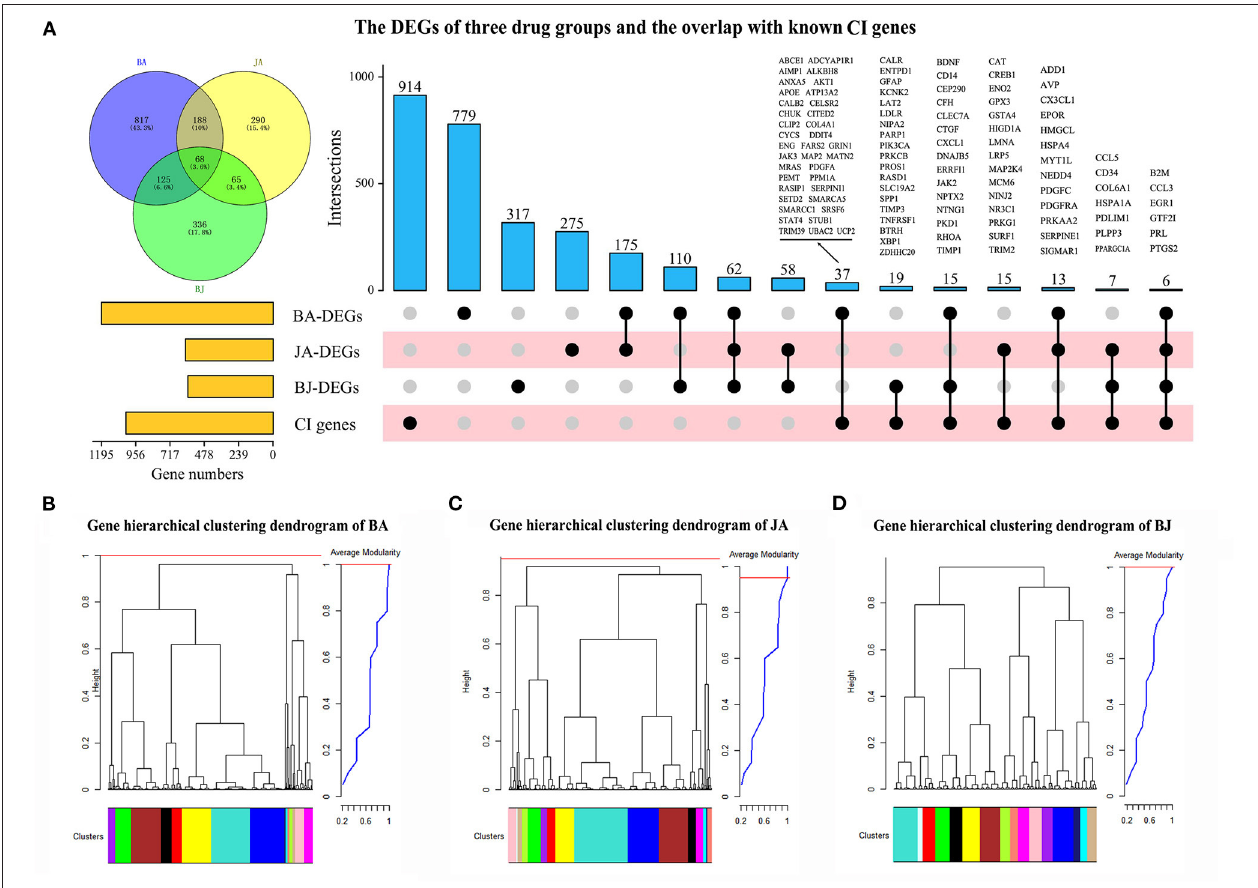
FIGURE 1 | The differentially expressed genes (DEGs) and co-expression modules of three-drug groups. (A) The number of DEGs for Baicalin (BA), Jasminoidin (JA), and their combination BJ, and their overlapped genes compared with known cerebral ischemia (CI) related genes. (B–D) Hierarchical clustering dendrogram of BA, JA, and BJ, the cluster tree branches labeled by colors were represented modules which were obtained by Dynamic Tree Cut algorithm with maximum average modularity. JA, respectively ( Figure 1A ). For the synergistic combination BJ group, there are 336 unique